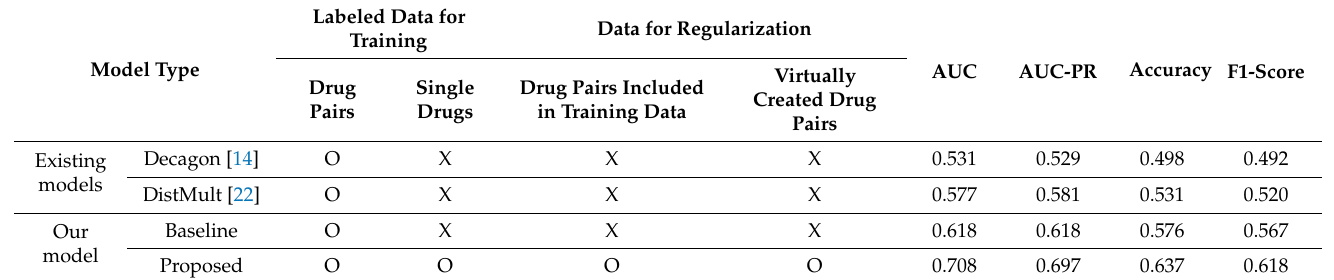
Table 2. DPU side effects prediction performance comparison with existing models trained with our